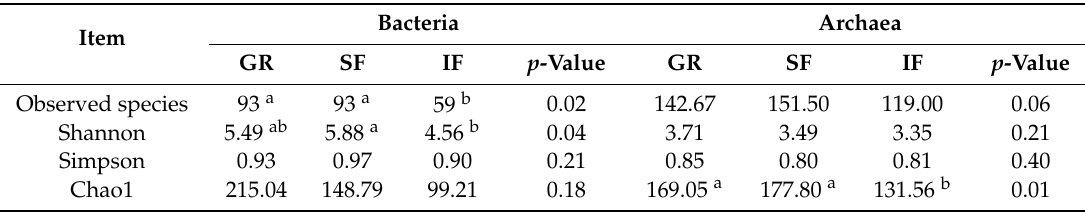
Table 2. Alpha diversities of bacteria and archaea in the rumen fluid of the goat kids among the three groups.